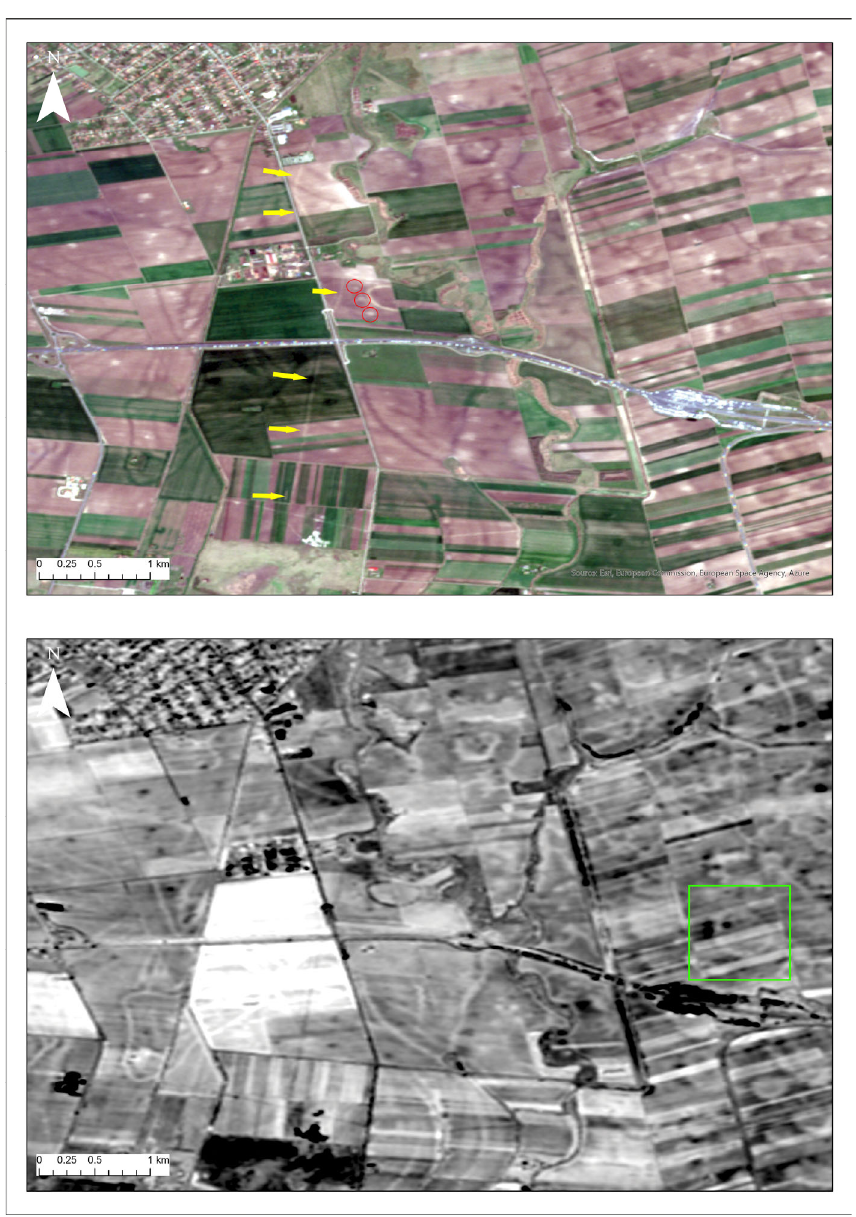
Figure 7. Gram–Schmidt pan ‐ sharpening Sentinel ‐ 2 image over Csanádpalota ‐ Juhász T. tanya ( top ); results after the implementation of the orthogonal transformation ( bottom ). Specific areas shown with arrows, circles, and squares are discussed in the paper.